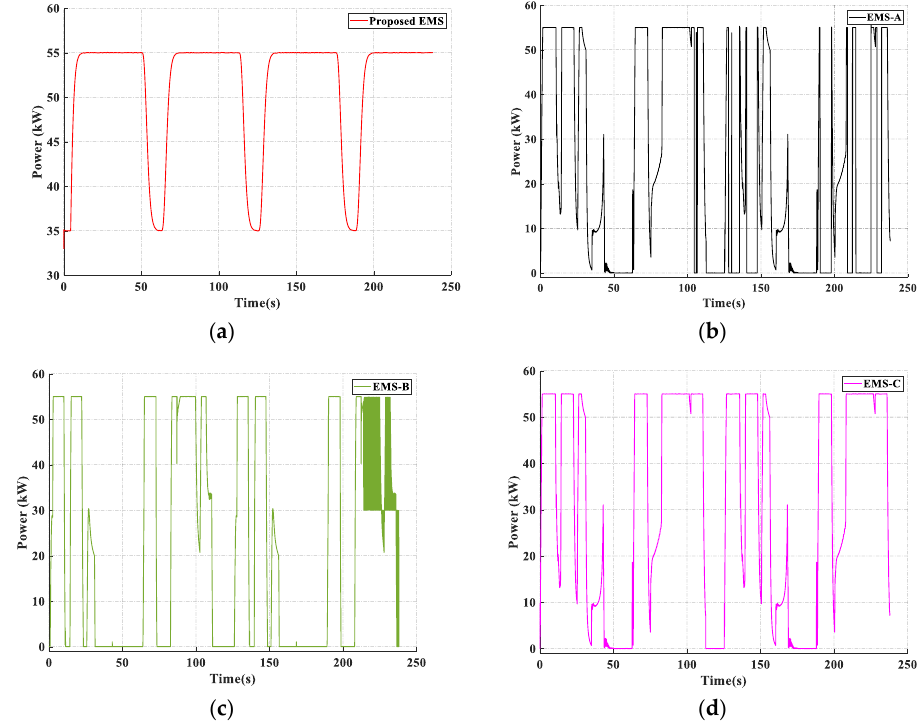
Figure 17. Power from the fuel cell in the proposed case and conventional cases. ( a ) Proposed EMS; ( b ) EMS-A; ( c ) EMS-B; ( d ) EMS-C.